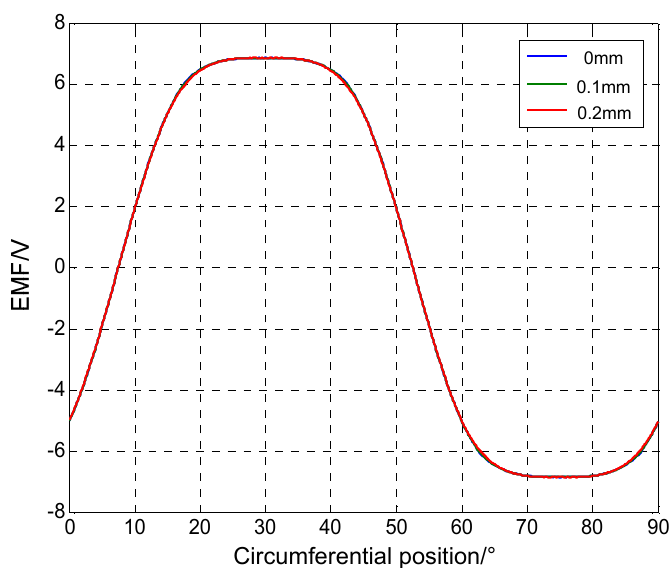
Figure 14. Comparison of EMF waveforms with skew in a variable period.